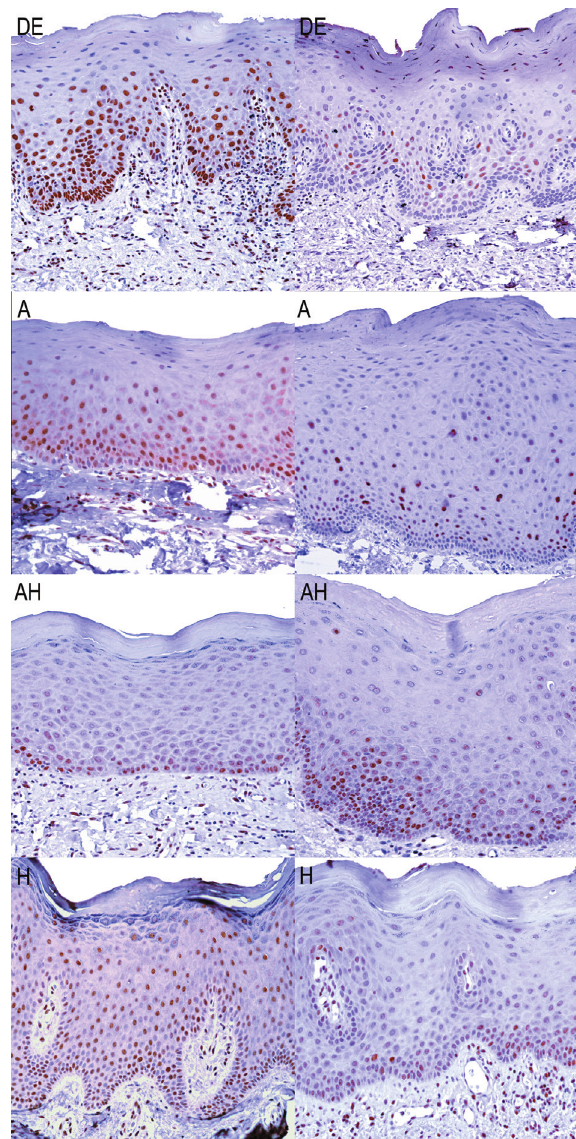
Figure 1- p53 and p21 WAF1 expression in oral leukoplakias. Leukoplakias with: epithelial dysplasia (DE); acanthosis (A); acanthosis in combination with hyperkeratosis (AH); hyperkeratosis (H). p53 and p21 WAF1 immunohistochemical expressions are shown in the left and right columns,